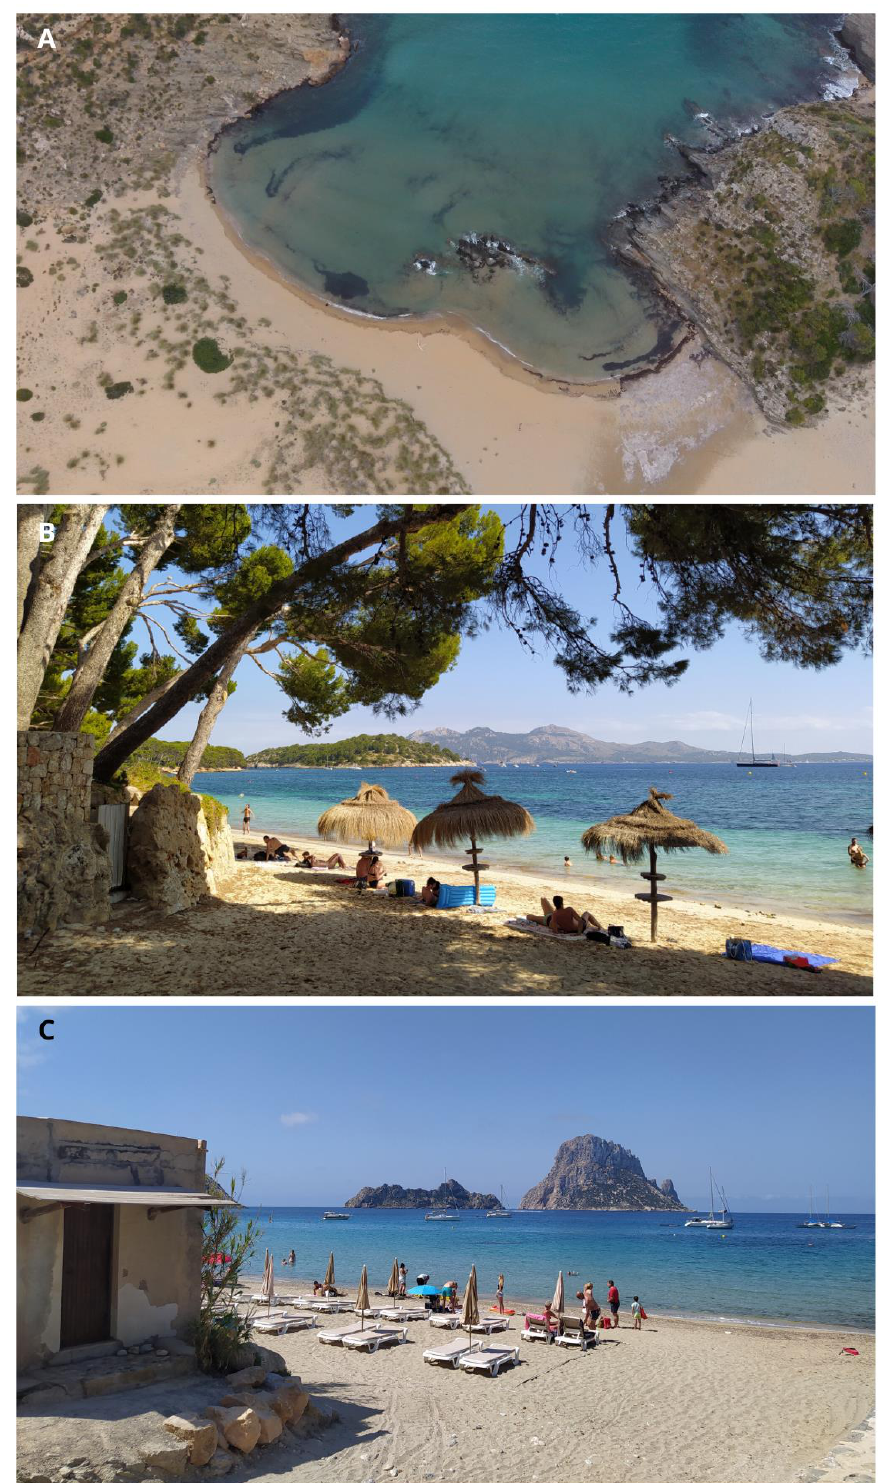
Figure 3. Examples of sites classified in classes I, II and III, respectively, Mongofra, Menorca ( A ), Formentor, Mallorca ( B ) and Cala d’Hort, Ibiza ( C ).